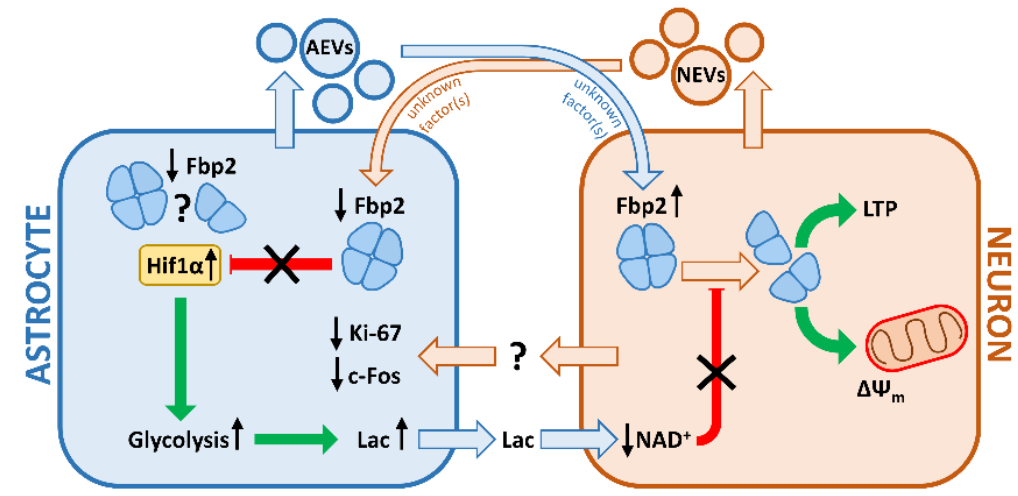
Figure 8. Overview of the key changes induced by the co-culturing of astrocytes and neurons (see text). AEVs—astrocytic extracellular vesicles; NEVs—neuronal extracellular vesicles; Lac—lactate; ΔΨm—mitochondrial membrane potential.